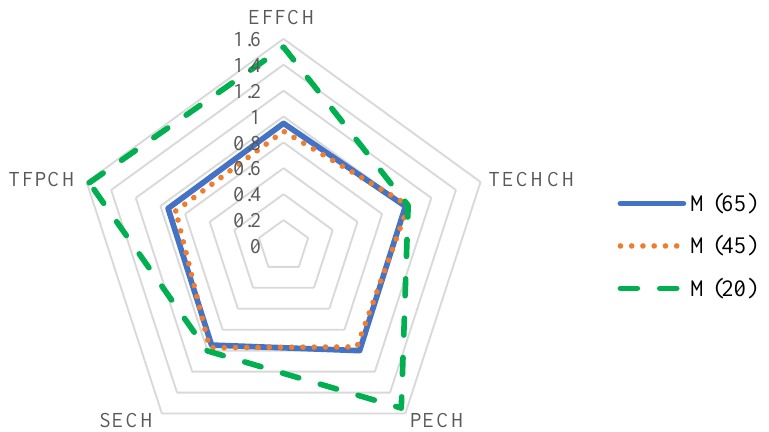
Figure 2. Decomposition mean table of enterprise total factor productivity.